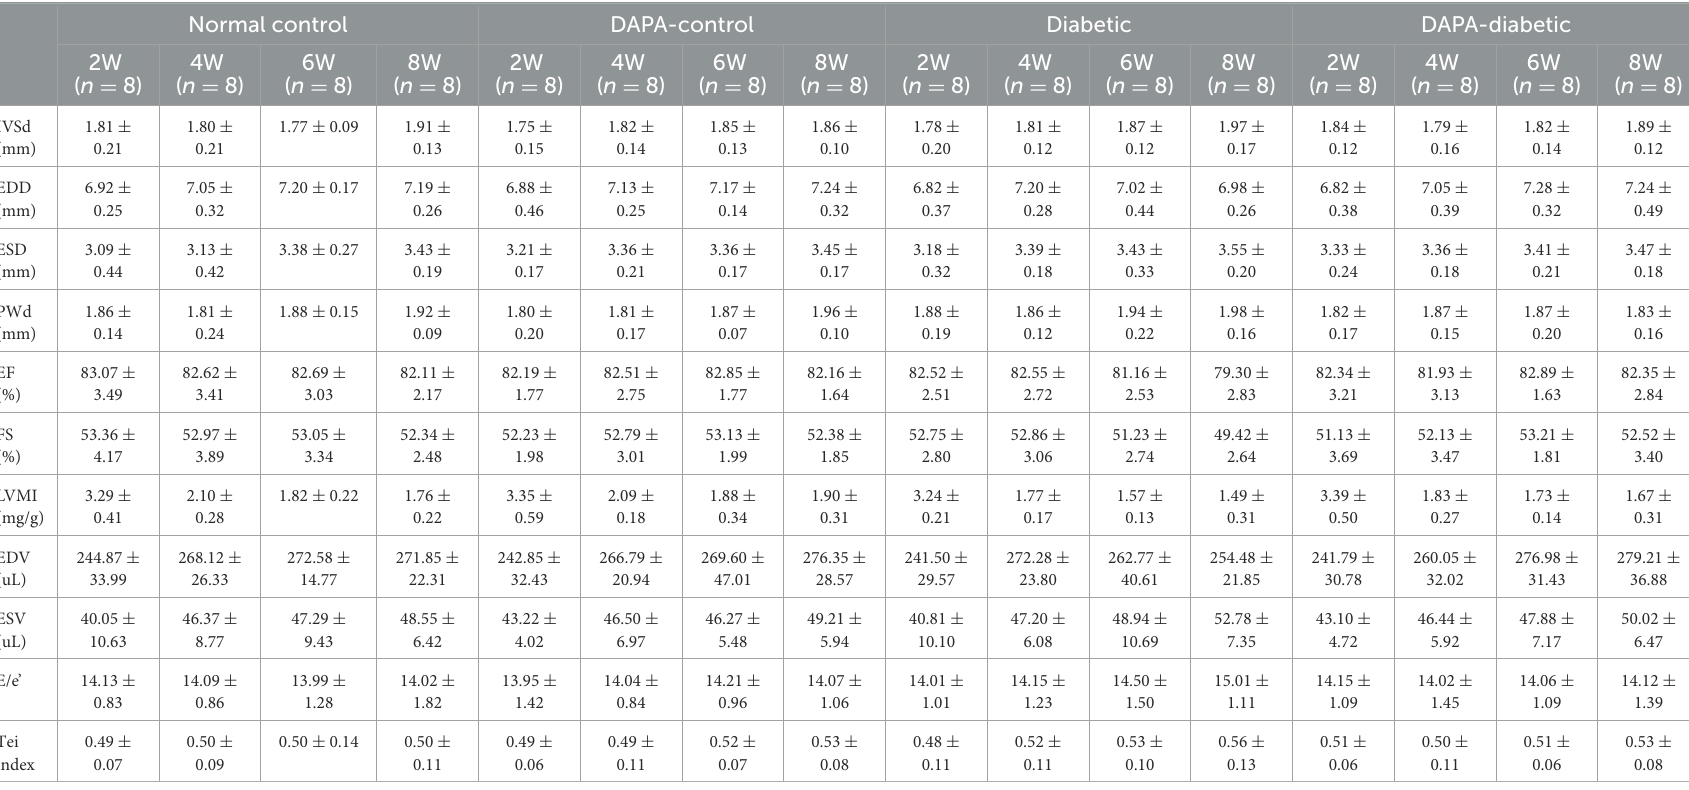
TABLE 1 Conventional echo-Doppler